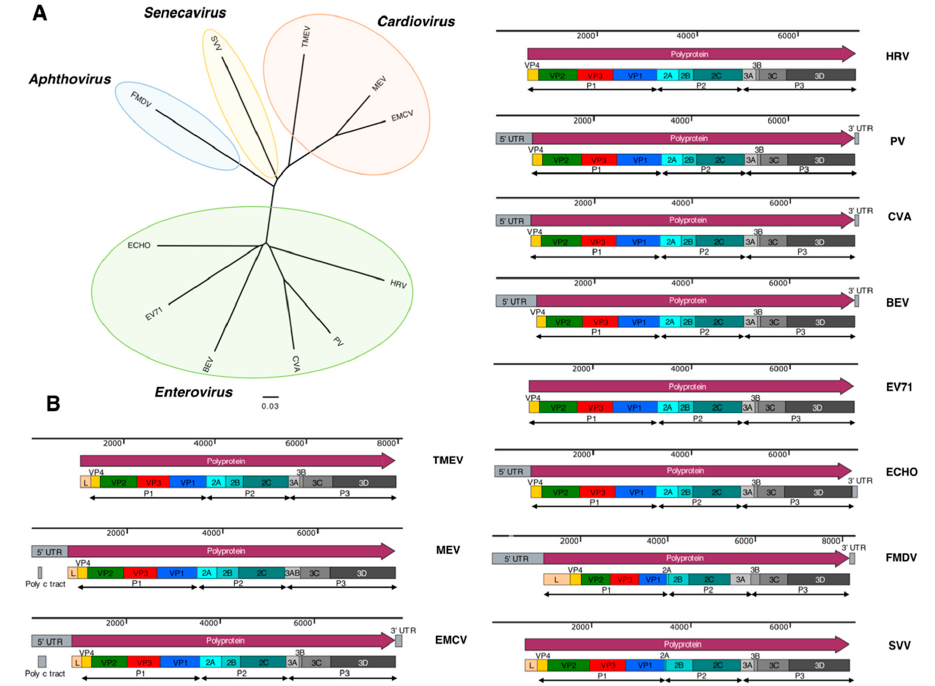
Figure 3. Genome-based phylogeny of di ff erent picornaviruses. ( A ) A radial phylogenetic tree demonstrating the evolutionary relationship among some members of Enterovirus , Aphthovirus , Senecavirus and Cardiovirus genera. Complete RNA sequences were aligned using Clustal Omega. Multiple alignment tool, scale bar representing number of nucleotide changes per site [29]. ( B ) RNA genome, polyprotein and cleaved mature peptides of di ff erent picornaviruses. Picornaviruses